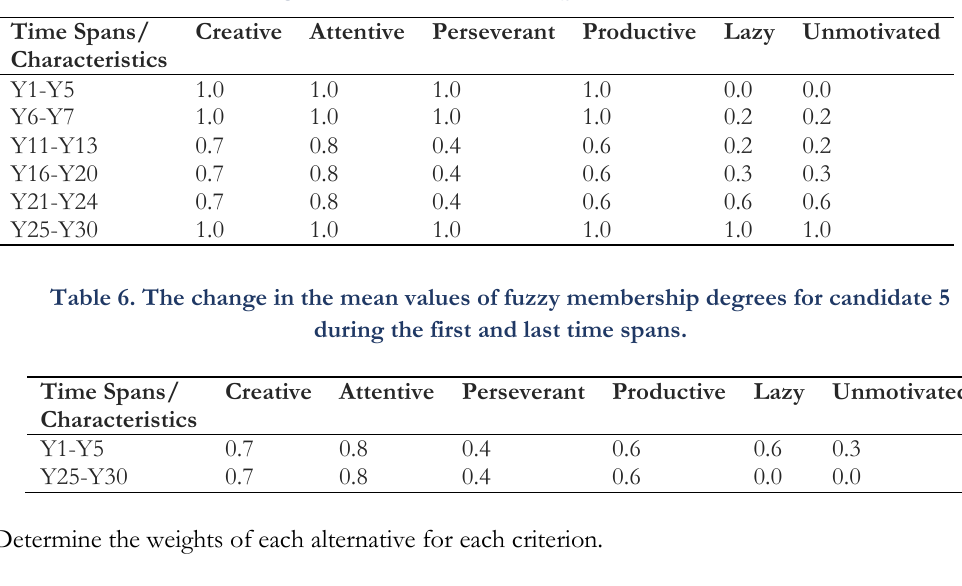
Table 5. The change in the mean values of fuzzy membership degrees for candidate 1 during 30 years in several time spans.